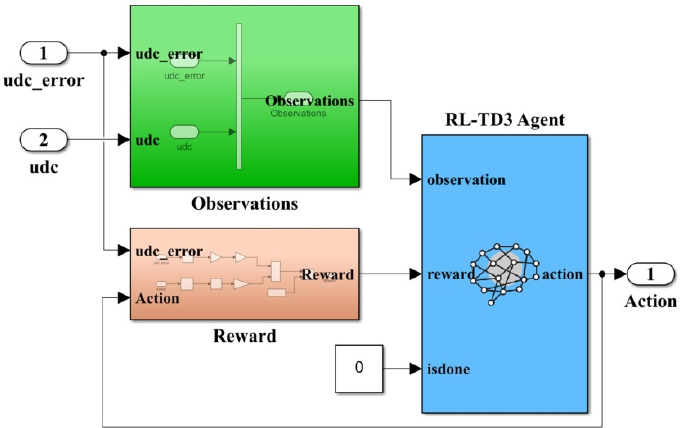
Figure 9. The MATLAB Simulink subsystem of the RL-TD3 agent for the correction of the i dref command.